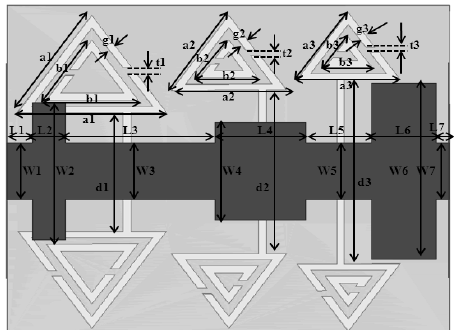
Fig. 3: Proposed design for microstrip low pass filter with triangular CSRR-DGS